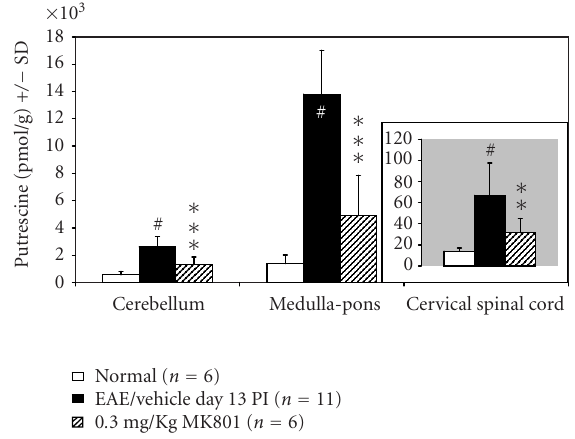
Figure 4: Putrescine levels detected in the CNS of normal and acute EAE rats 13 days postinoculation (PI), with and without MK801 treatment. MK801 was administered intraperitoneally for 6 days from day 7 PI at a concentration of 0.3mg/Kg body weight in sterile phosphate bu ff ered saline. Putrescine levels at day 13 PI are significantly increased in all tissues compared to normal (# P < . 001; Student t test). MK801 significantly reduced elevated putrescine at day 13 PI in all CNS areas ( ∗∗ P < 0 . 01, ∗∗∗ P < . 001; Student t